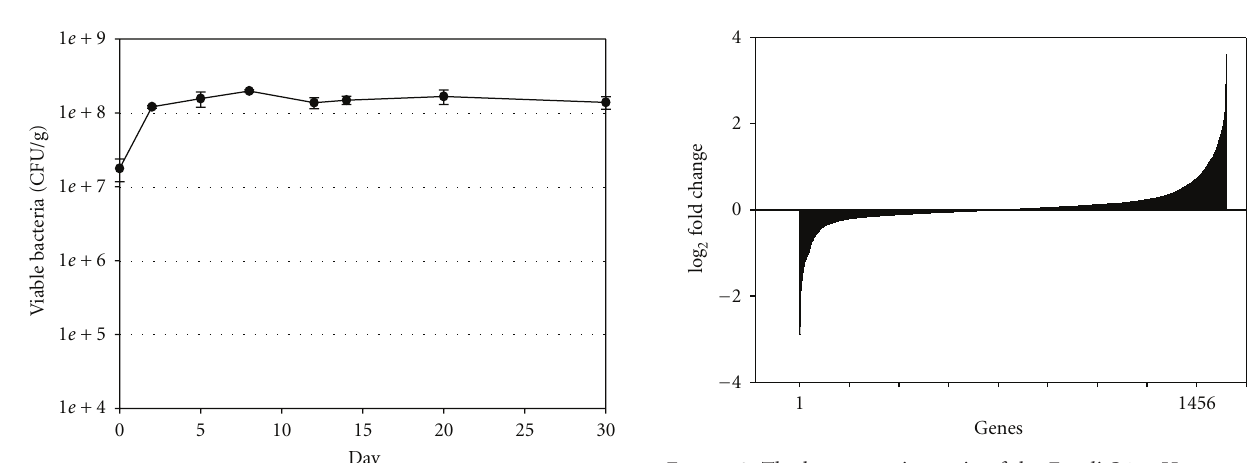
Figure 3: The log expression ratio of the E . coli O157:H7 genome was plotted for Luria broth versus sterile stream water. Genes more highly expressed in LB have a negative value, whereas genes more highly expressed in water have a positive value.